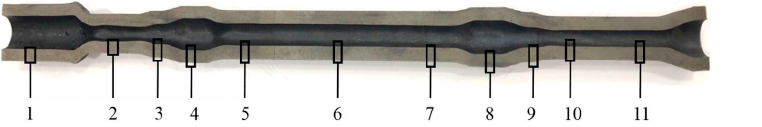
Figure 17. Rail axles produced in 1:5 scale after machining allowance removal and shot peening [20] (Reprinted from ref. [20]).